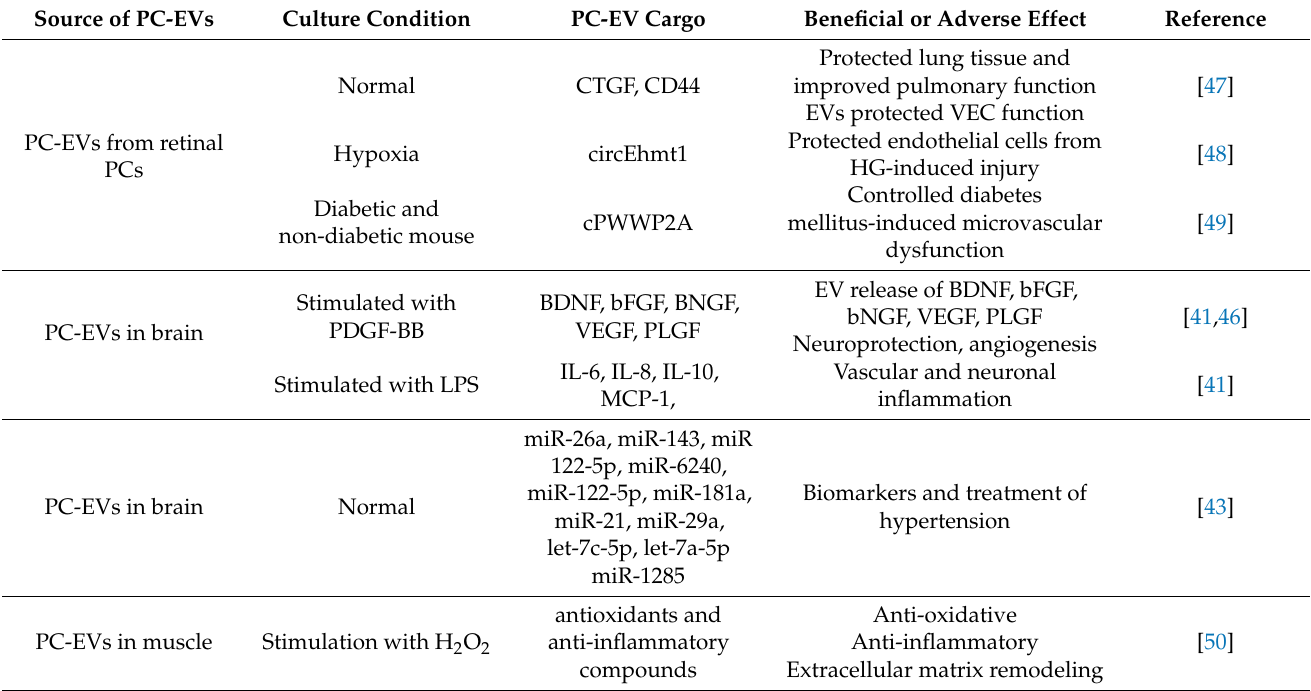
Table 1. PCs-EV cargo under normal and stimulated